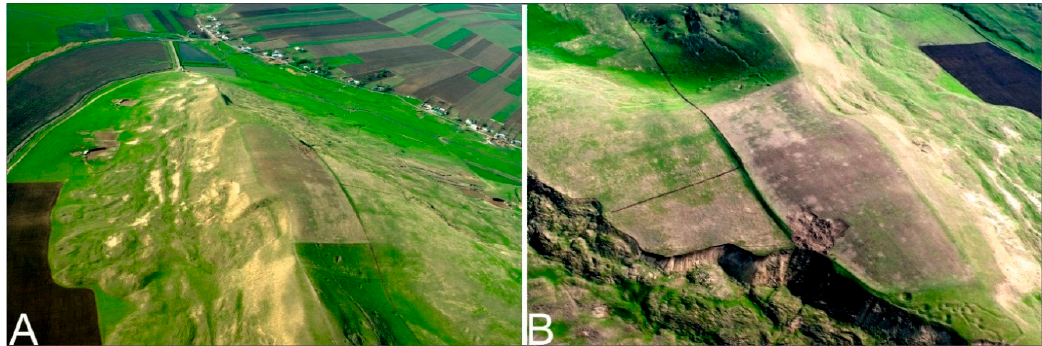
Figure 8. Oblique air photographs: ( A ) View from the S; ( B ) view from the NE.